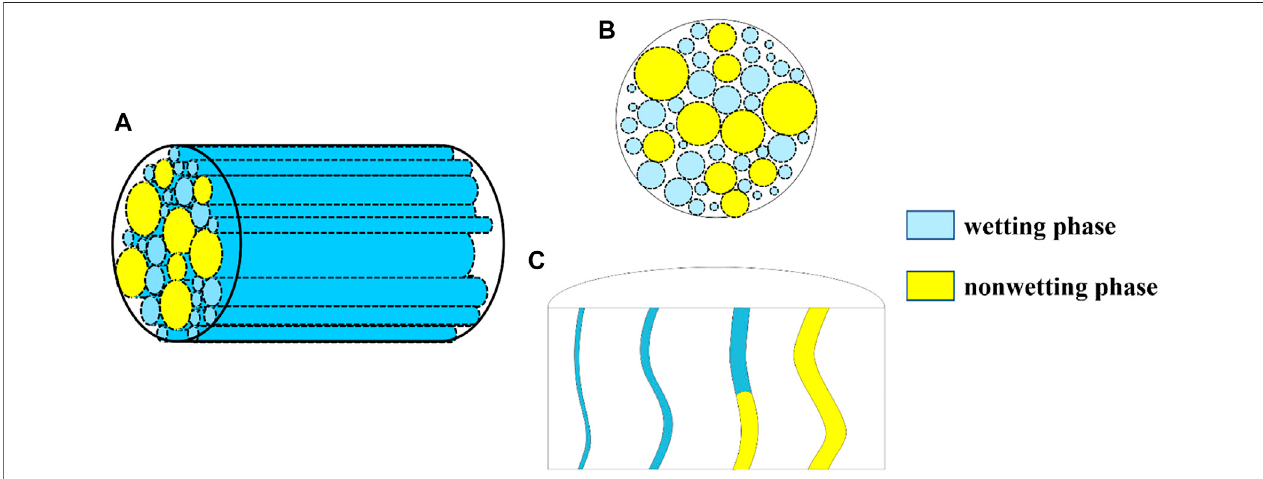
FIGURE 3 | A schematic diagram of fractal capillary bundle model of porous media. (A) 3D structure; (B) transverse view; (C) longitudinal view.